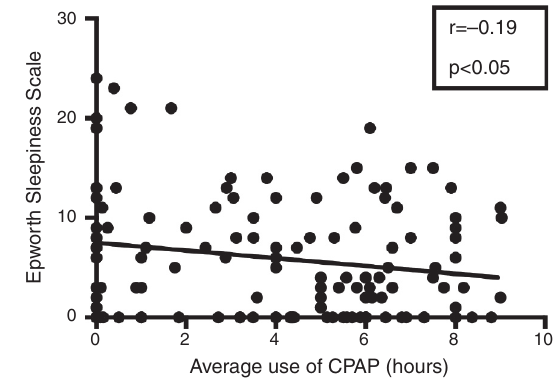
Table 2 Comparison of demographic data and frequency